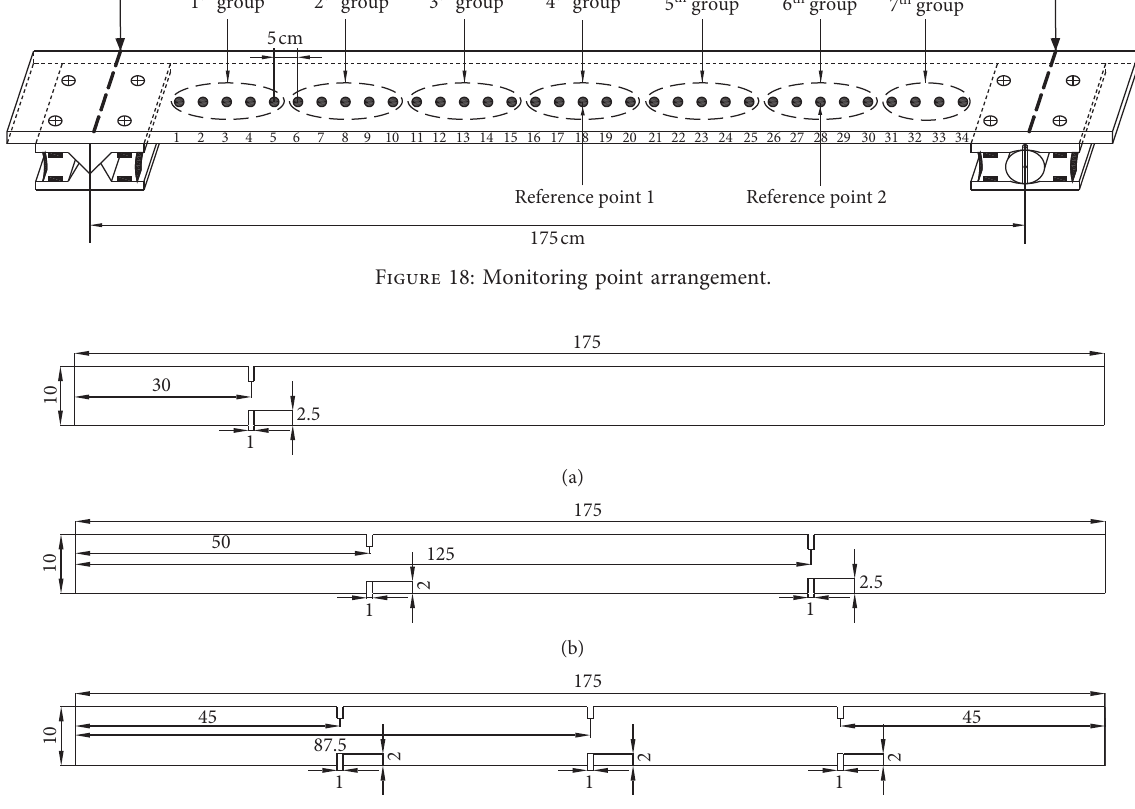
Figure 17: Test site.